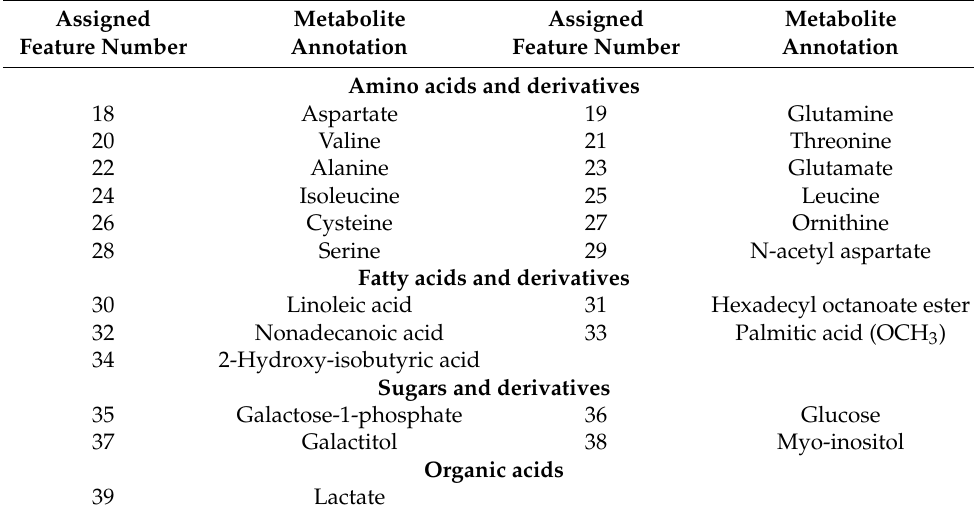
Table 2. Annotation of metabolites in methanolic extracts of Hyphozyma roseonigra analyzed